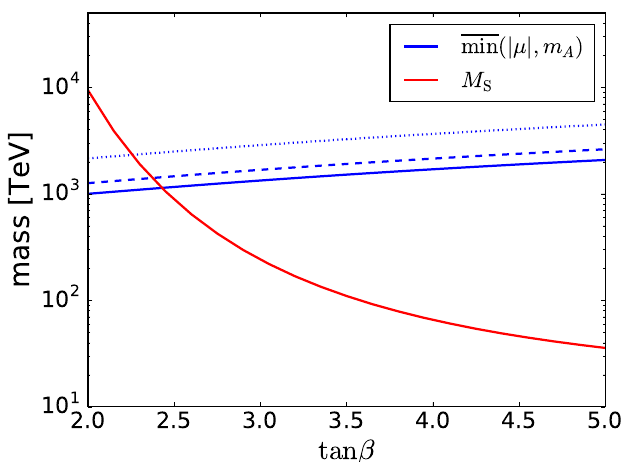
Figure 16 . min( j (cid:22) j ; m A ) as a function of tan (cid:12) taking the input value of j L j (= 800 TeV) of Sample Point 1 (blue lines). Solid, dashed, and dotted blue lines correspond to x min = 1, 0 : 3, and 0 : 1, respectively. M S is also shown in the red